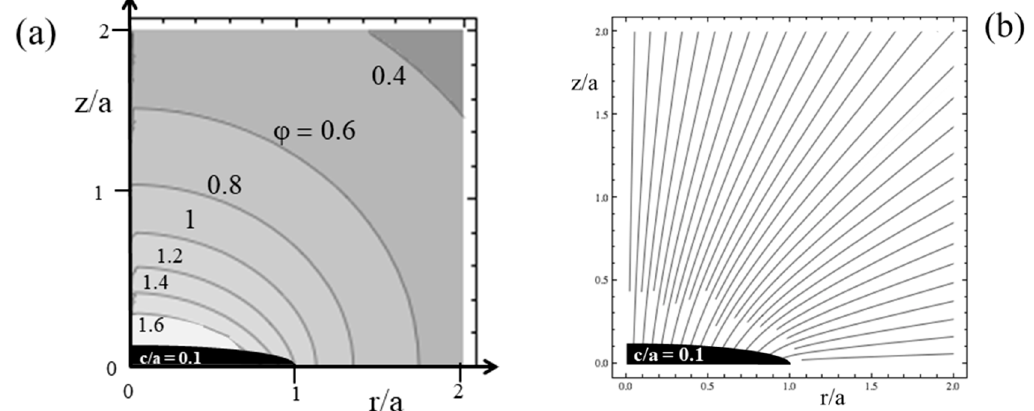
Figure 4. Newtonian attraction to a highly flattened constant density oblate spheroid (black shape) with a 1:10 axial ratio similar to those of spiral galaxies. One quadrant is shown: ( a ) contour plot of the Newtonian gravitational potential exterior to the oblate, shown in units of G Mm / a ; ( b ) lines of exterior force. Reprinted from Figure 7e,f in Reference [58], with permission from Elsevier.